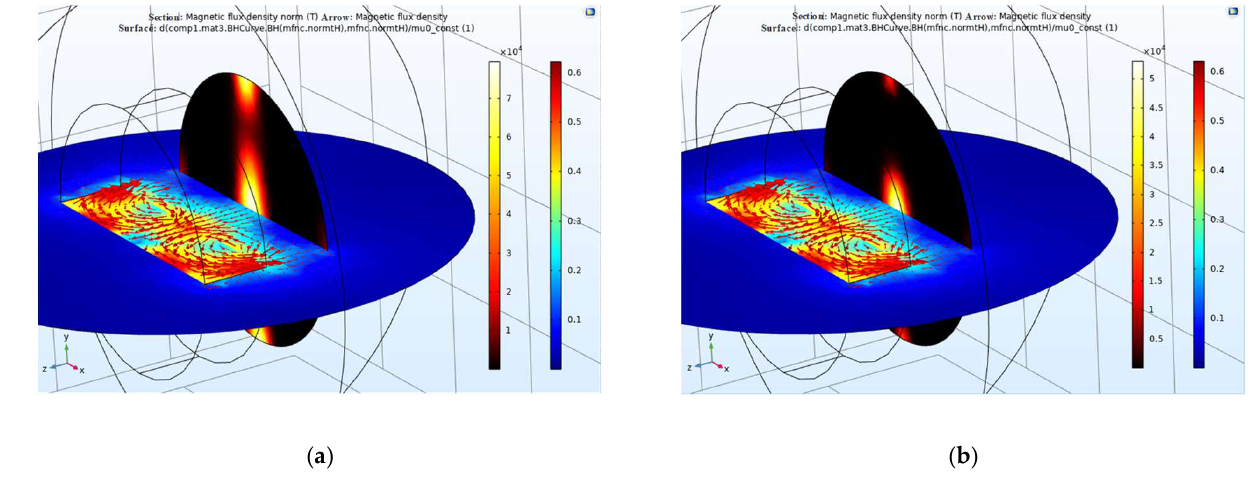
Figure 7. Amorphous-alloy shell depending on the flux variation: ( a ) annealing temperature 350 °C and ( b ) annealing temperature above Curie temperature at 450 °C.